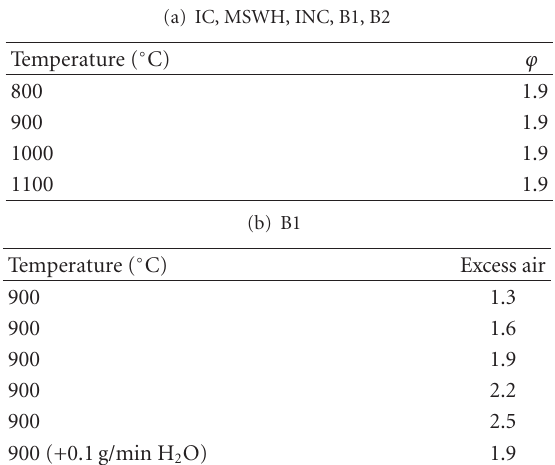
Table 2: Experimental